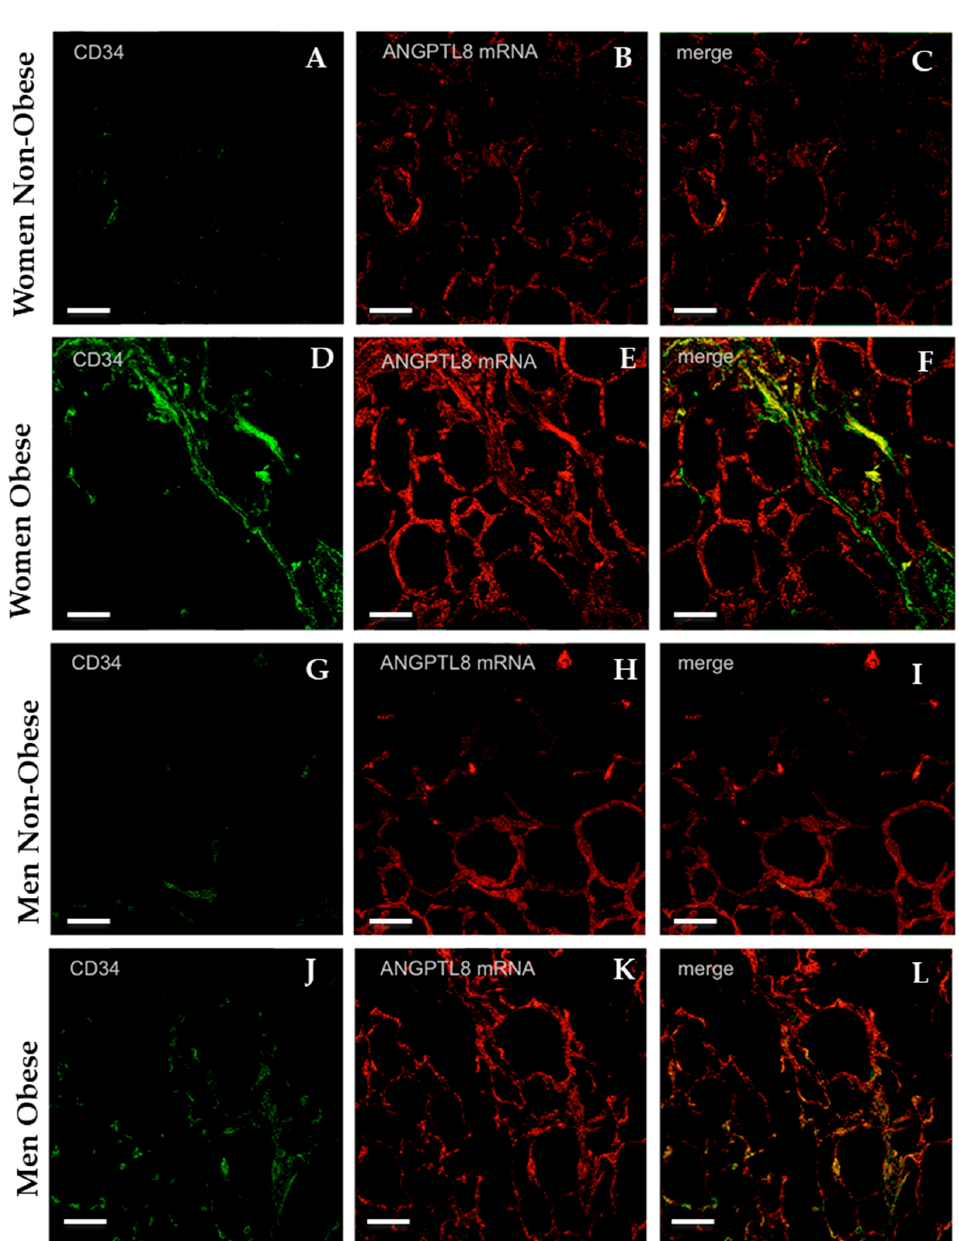
Figure 5. Representative images showing the immunofluorescence reaction for the endothelial cells’ marker anti-CD34 in adipose tissue (micrographs A , D , G , J , in green). The micrographs B , E , H , K present the in situ hybridisation for ANGPTL8 in VAT (ANGPTL8 mRNA, in red). The micrographs C , F , I , and, L are the merge of both images, (non-obese women, n = 4), (obese women, n = 4), (non-obese men, n = 4), (obese men, n = 4). Scale bar: 60 µm.